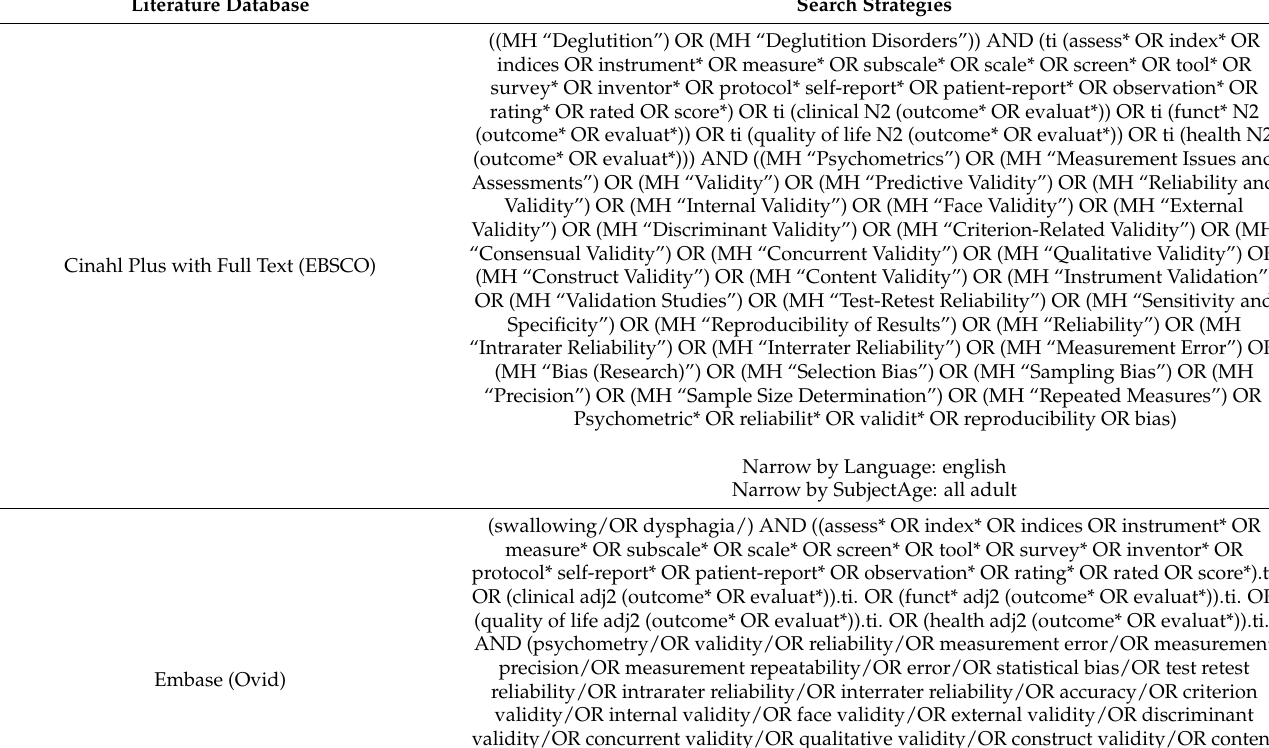
Table 1. Search terms per